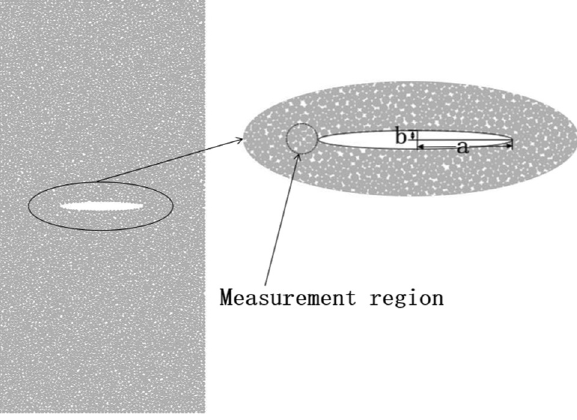
Figure 2: Partial enlarged view of prefabricated elliptical